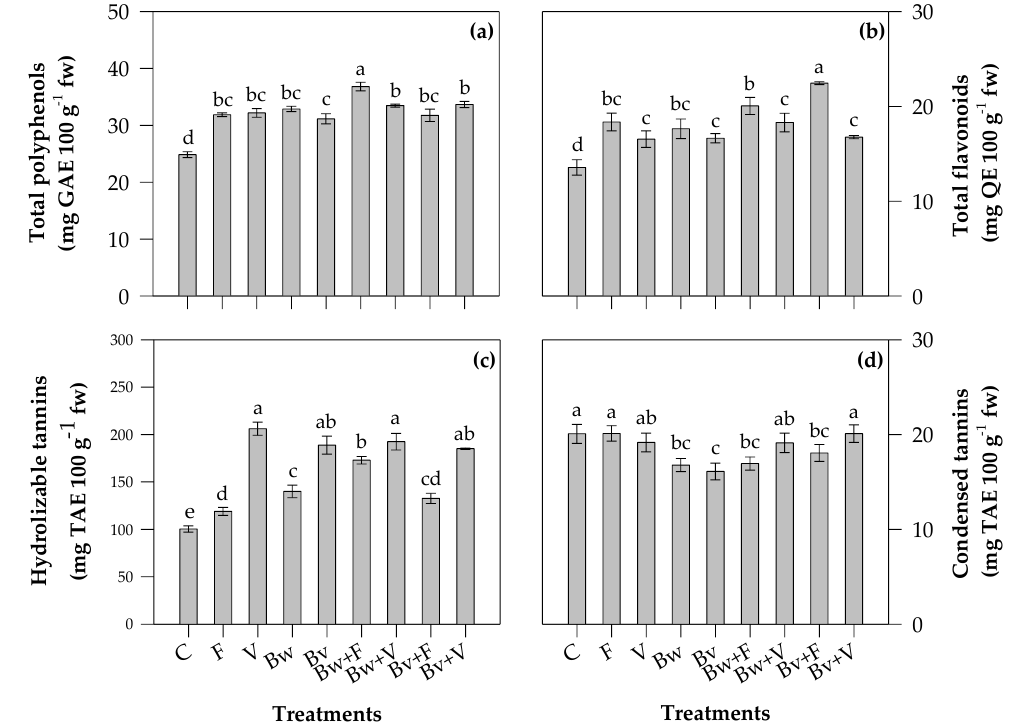
Figure 2. Total polyphenol (mg GAE 100 g − 1 fw) ( a ), total flavonoid (mg QE 100 g − 1 fw) ( b ), hydrolyzable tannin (mg TAE 100 g − 1 fw) ( c ) and condensed tannin (mg TAE 100 g − 1 fw) ( d ) contents of Swiss chard leaves. C, control; F, ammonium nitrate; V, vermicompost; Bw, biochar from wood chips; Bv, biochar from vine prunings; Bw+F and Bv+F, biochars respectively mixed with ammonium nitrate; Bw+V and Bv+V, biochars respectively mixed with vermicompost. Values are means (n = 3) ± s.e. Different letters above histograms indicate significant differences among treatments (p ≤ 0.05; Tukey’s test).